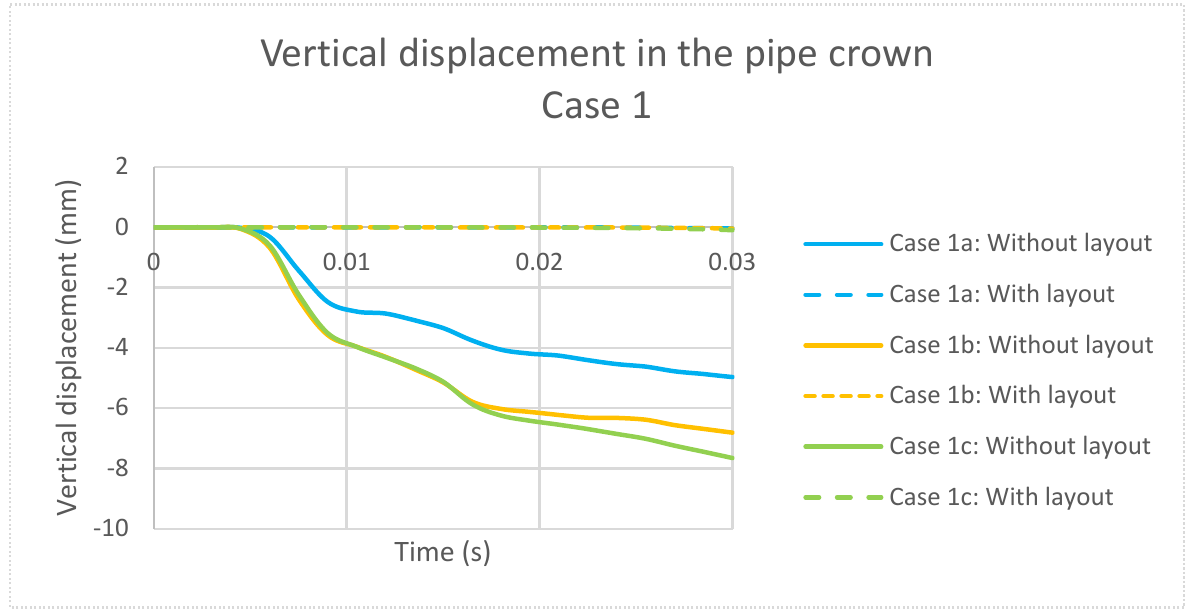
Figure 7. Vertical displacements in the pipe crown for case 1.